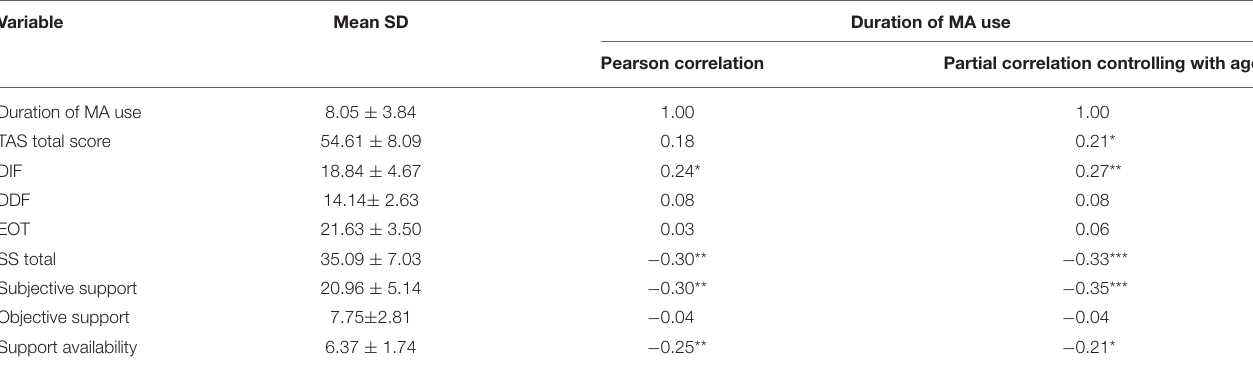
TABLE 3 | Correlation matrix of methamphetamine use duration, social support rating scale and twenty–item Toronto alexithymia scale scores of the methamphetamine-dependent patients (Mean ± SD). Variable